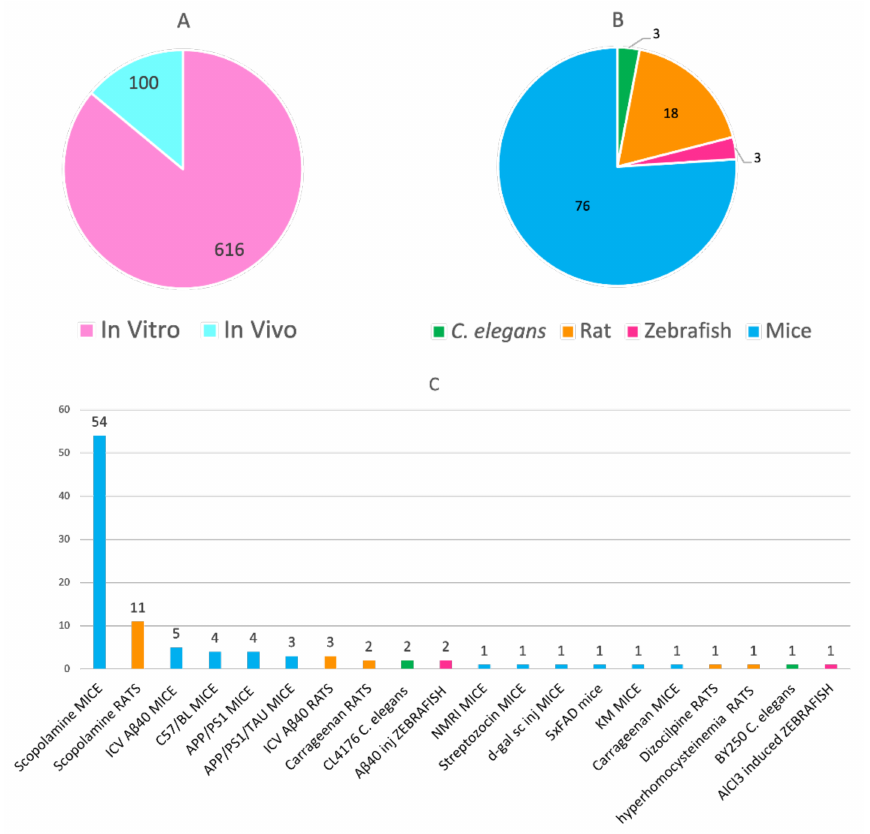
Figure 5. Number of in vitro and in vivo studies ( A ); type of animals ( B ) and specific models ( C ) used for the pharmacological evaluation of multitarget anti-AD compounds in the period